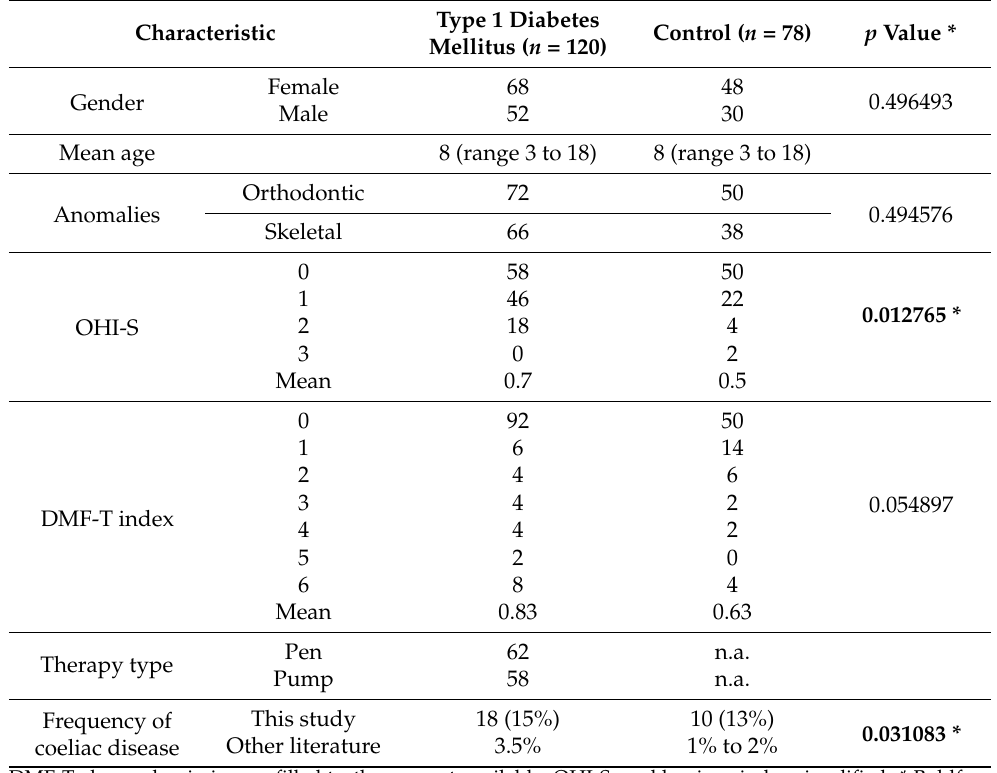
Table 1. On-site screening data